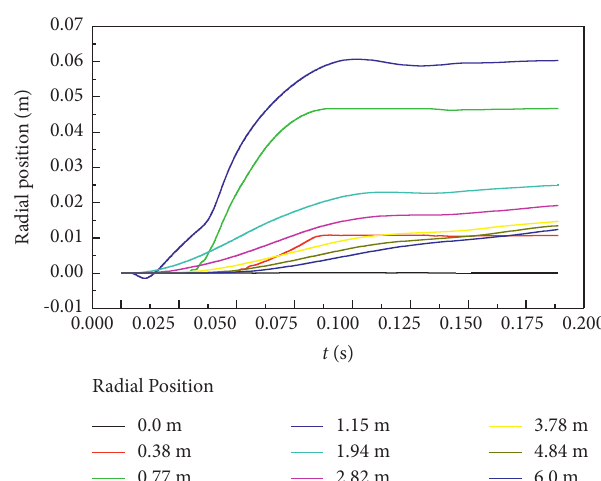
Figure 14: Radial displacement of surface